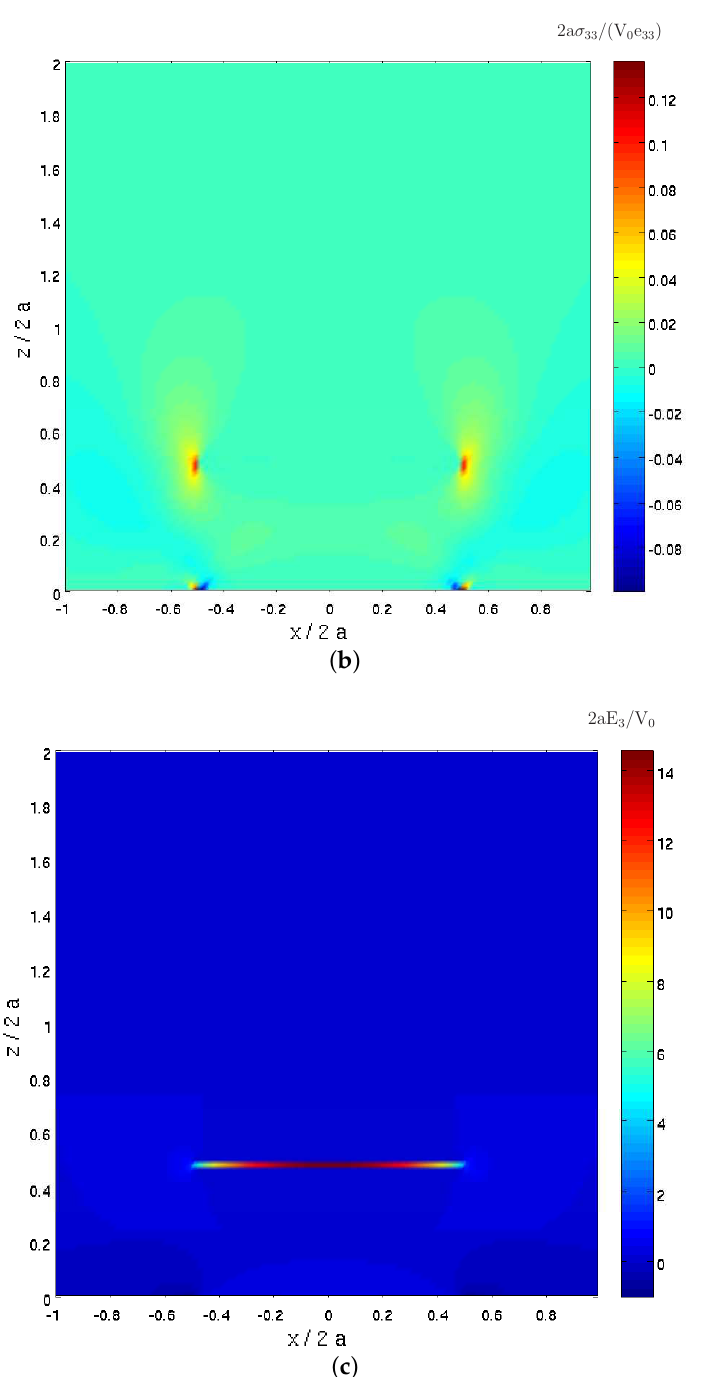
Figure 7. A piezoelectric half-plane which consists of periodic PZT-7A and cadmium selenide layers: An electrode of electric potential V 0 is attached to the PZT-7A layer at the surface z = 0, and a short crack of length 2 a is located at z = a within the cadmium selenide layer. ( a ) The variations of the induced normal stress σ 33 , electric displacement D 3 , and electric field E 3 along the crack line at z / a = 1. ( b ) The distribution of the induced normal stress σ 33 in the region − 1 ≤ x /2 a ≤ 1, z /2 a ≤ 2. ( c ) The distribution of the normal component of the electric field E 3 in the region − 1 ≤ x /2 a ≤ 1, z /2 a ≤